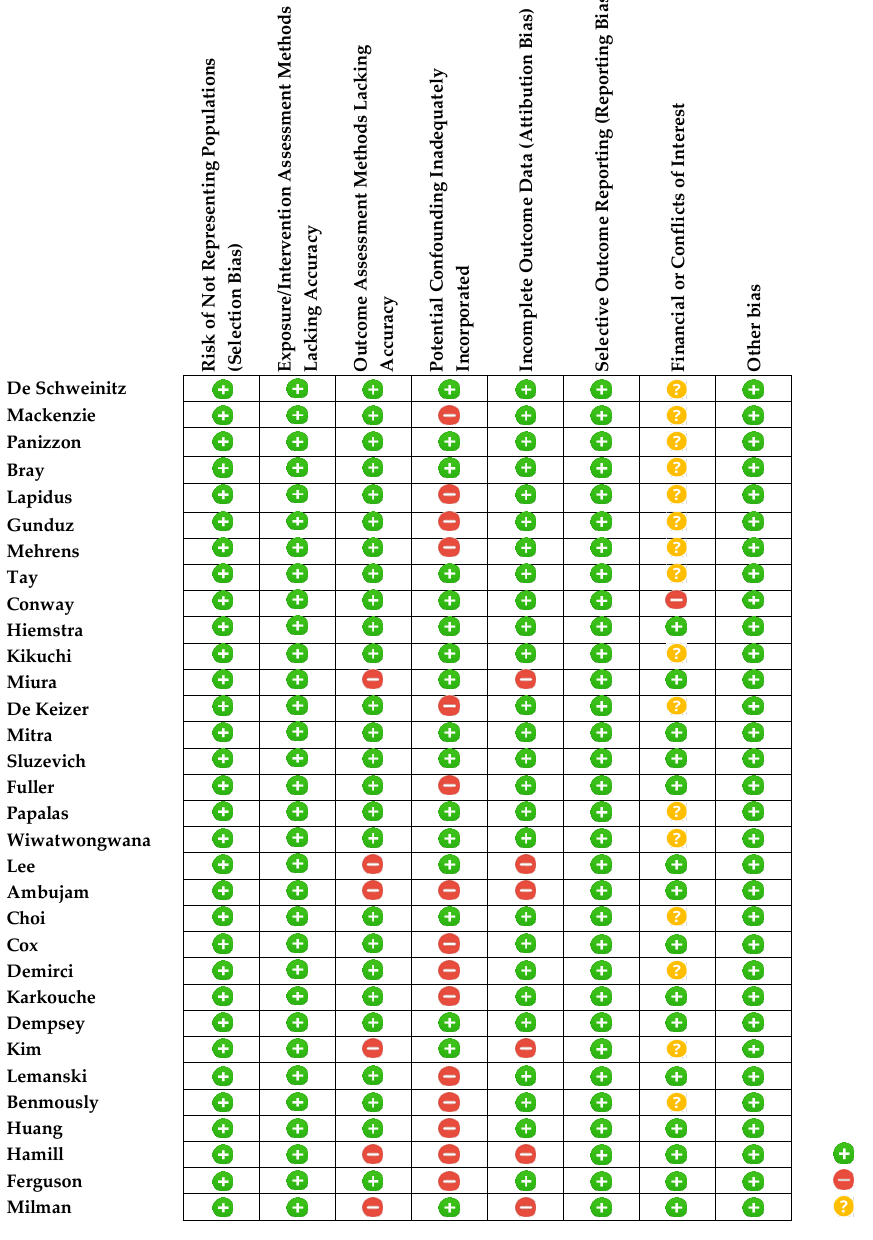
Figure 6. Risk of bias summary: judgements about each risk of bias item for each included study [5–36]. ROB = Risk of bias.